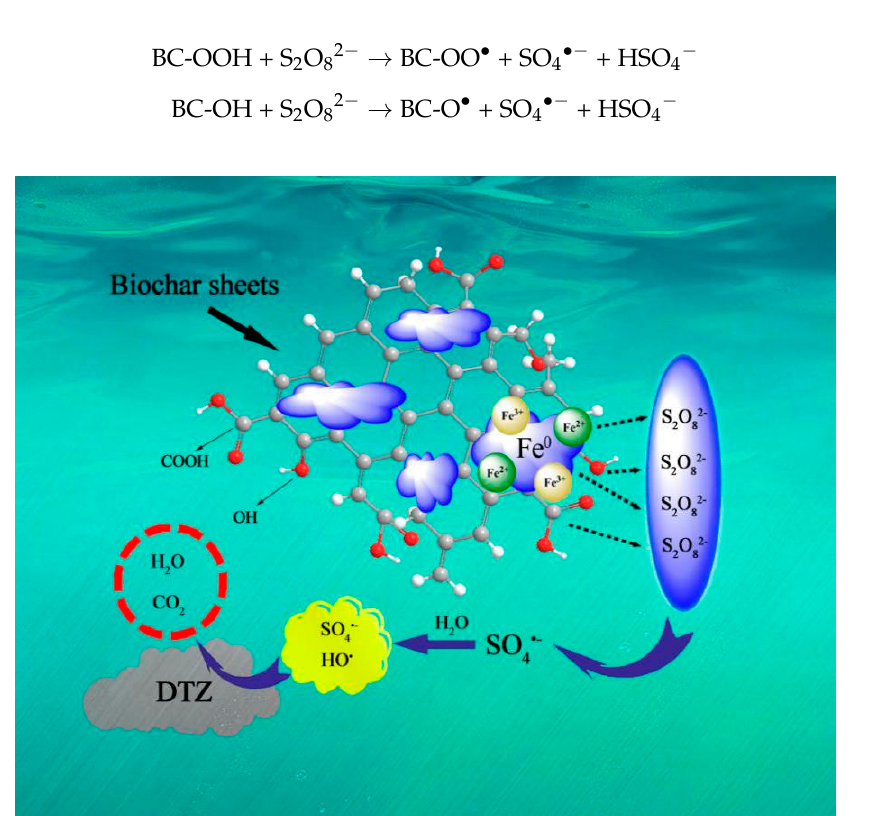
Figure 10. The mechanism of nZVI/BC activating PS for the degradation of DTZ. [DTZ] = 20 mg L − 1 ; [nZVI/2BC] = 0.45 g L − 1 ; [PS] = 25.0 mM; Temp= 25 °C; pH = 7.0.